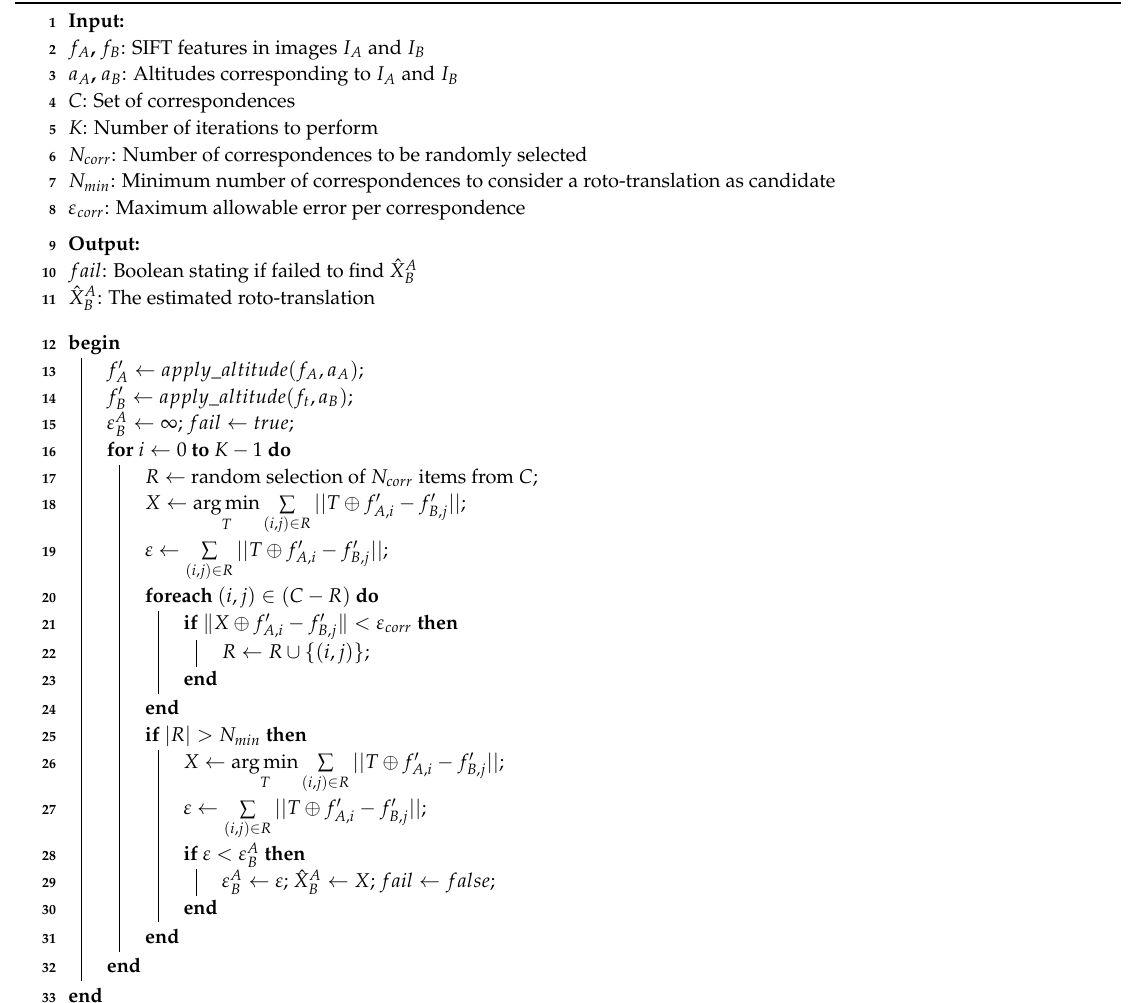
from image I A to image I B B